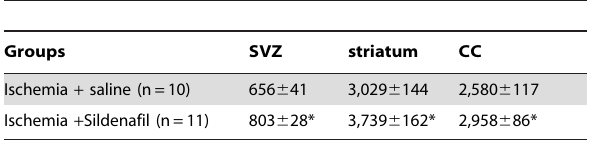
Table 1. The number of YFP + cells in the ischemic